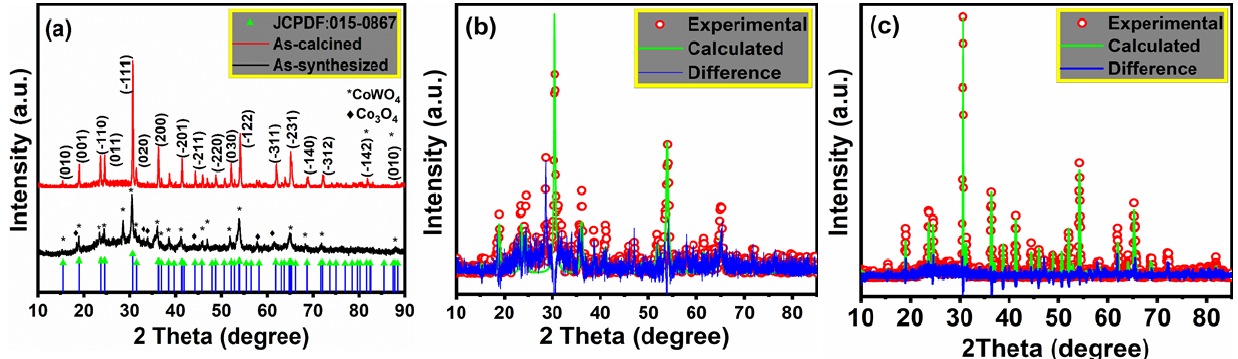
Figure 1. ( a ) X-ray powder diffraction patterns with JCPDF card and Rietveld refinement profile of the ( b ) as-synthesized and ( c ) calcined Ni-CoWO 4 NPs.